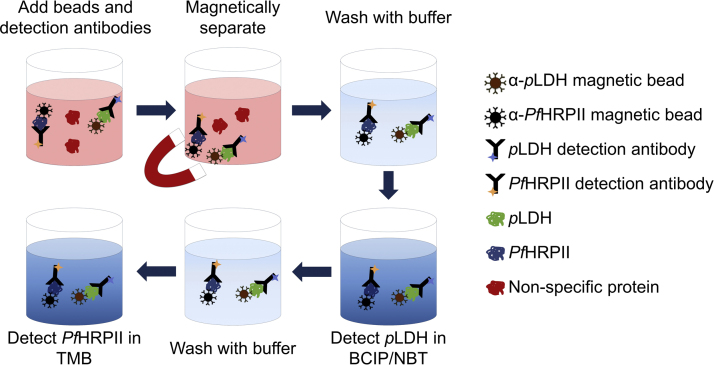
Workflow for on-bead SCSD ELISA for pLDH and PfHRPII.